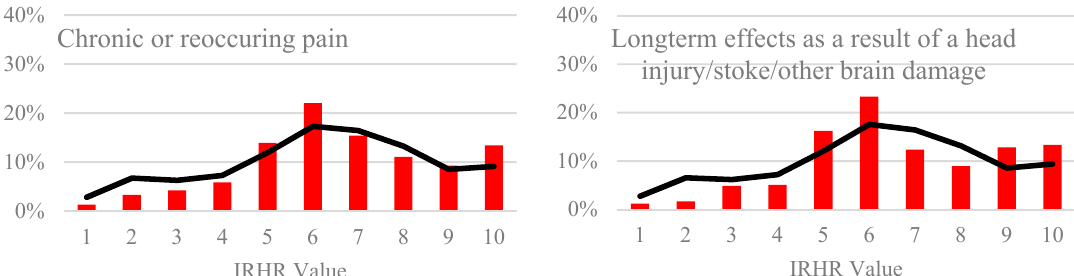
Figure 3. Index of Relative Homelessness Risk by selected disability types (vertical column) versus without impairment (black line).